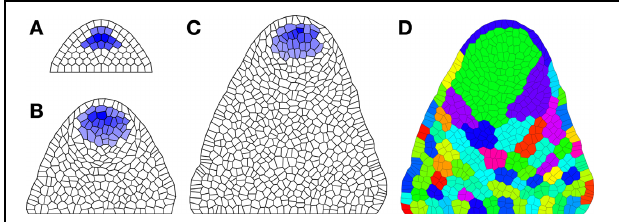
FIGURE 2 | Results of Wuschel simulation using Cellzilla. Species concentration is illustrated at the end of the simulation time course. The concentration of Wuschel is shown in blue, and protein Y is shown in green. Darker colors indicate higher concentrations, and white indicates a zero concentration. Steady state concentration of (A) Wuschel in wild-type simulation; (B) Wuschel in ablated meristem; (C) signal protein Y in ablated meristem. Parameters: v = 0 . 1, T WY = − 25, T WA = 0 . 5, h = 0, k w = 0 . 1, k y = 0 . 1, d = 0 . 5, D Y = 2, D A = 1 . 5, D B = 15.